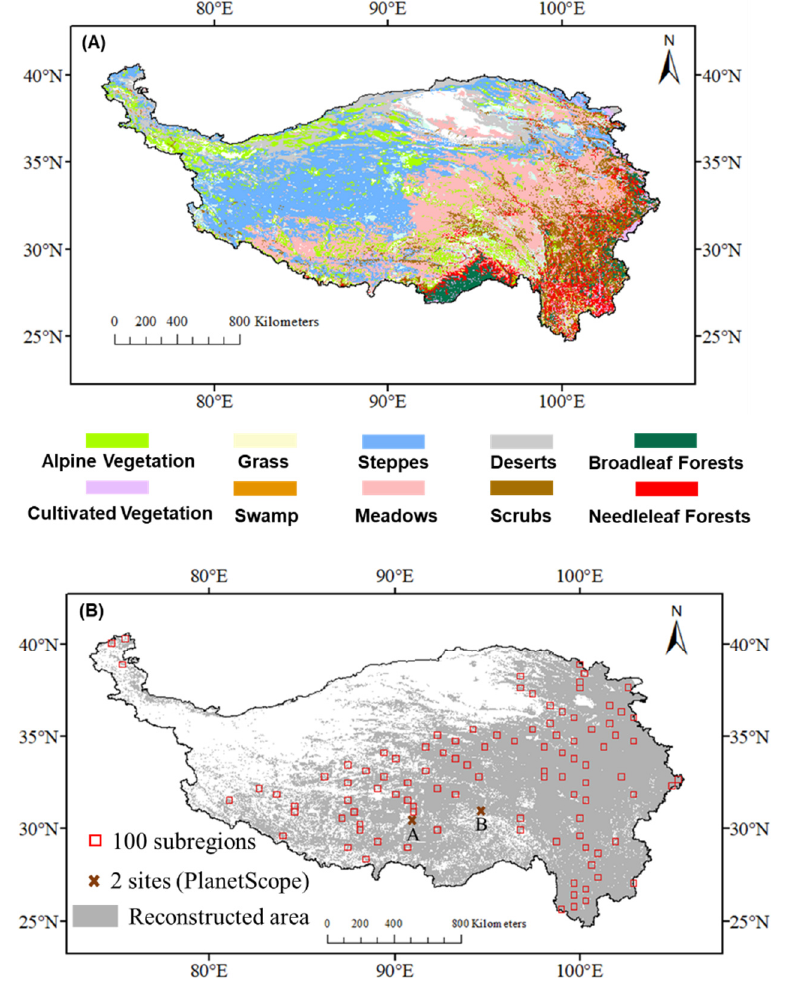
Figure 1. ( A ) The spatial distribution of the main vegetation types on the QTP, provided by The Vegetation Map of the Editorial Board of China (CAS) [31] ; ( B ) the vegetated areas in the QTP (gray color), where NDVI reconstruction was performed. The red squares represent the 100 randomly selected subregions for quantitative assessment with reference Landsat images. The two red crosses indicate the sites for which corresponding images were compared with PlanetScope images.